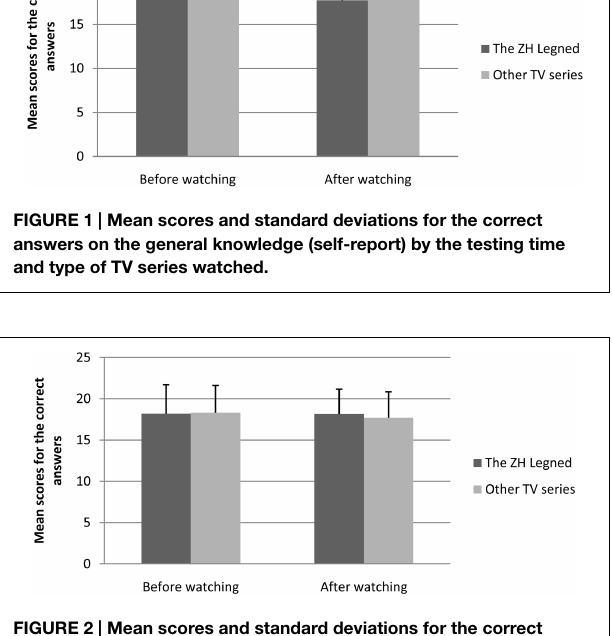
FIGURE 2 | Mean scores and standard deviations for the correct answers on the general knowledge (real score) by the testing time and type of TV series